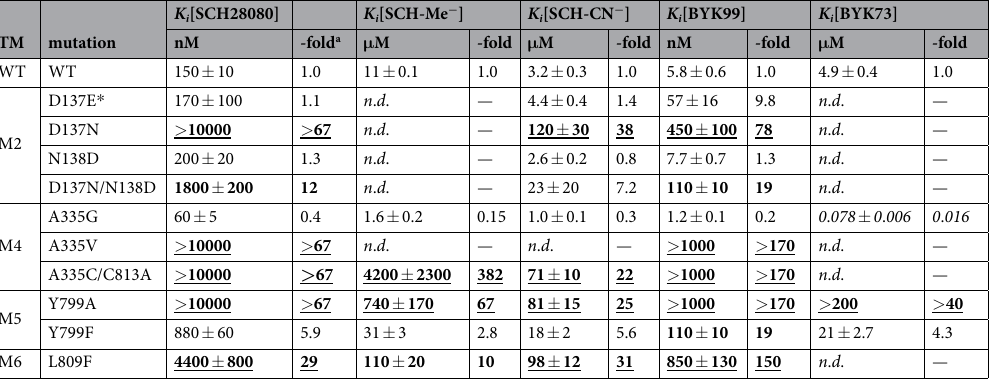
Table 3. Effect of mutation in D137, N138, and previously reported residues of H + ,K + -ATPase. Data are shown as in Tables 1 and